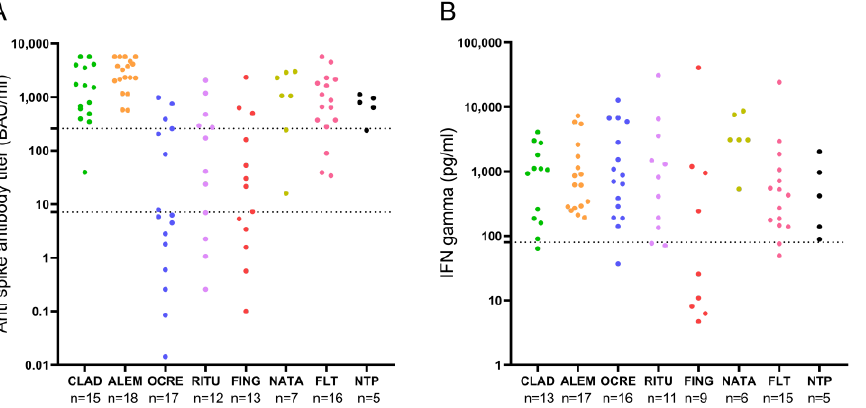
Figure 1. Post-vaccination anti-SARS-CoV-2 IgG titers ( A ) and IFN-γ levels ( B ) by disease-modify- ing therapy. ( A ) The lower dotted line marks anti-spike IgG antibody titers considered positive (7.1 BAU/mL), and the upper dotted line marks anti-spike IgG antibody titers considered protective (260 BAU/mL). ( B ) Dotted line marks IFN-γ levels of 80 pg/mL that were considered positive. ALEM: alemtuzumab; CLAD: cladribine; FING: fingolimod; FLT: first-line therapies; NATA: natalizumab;